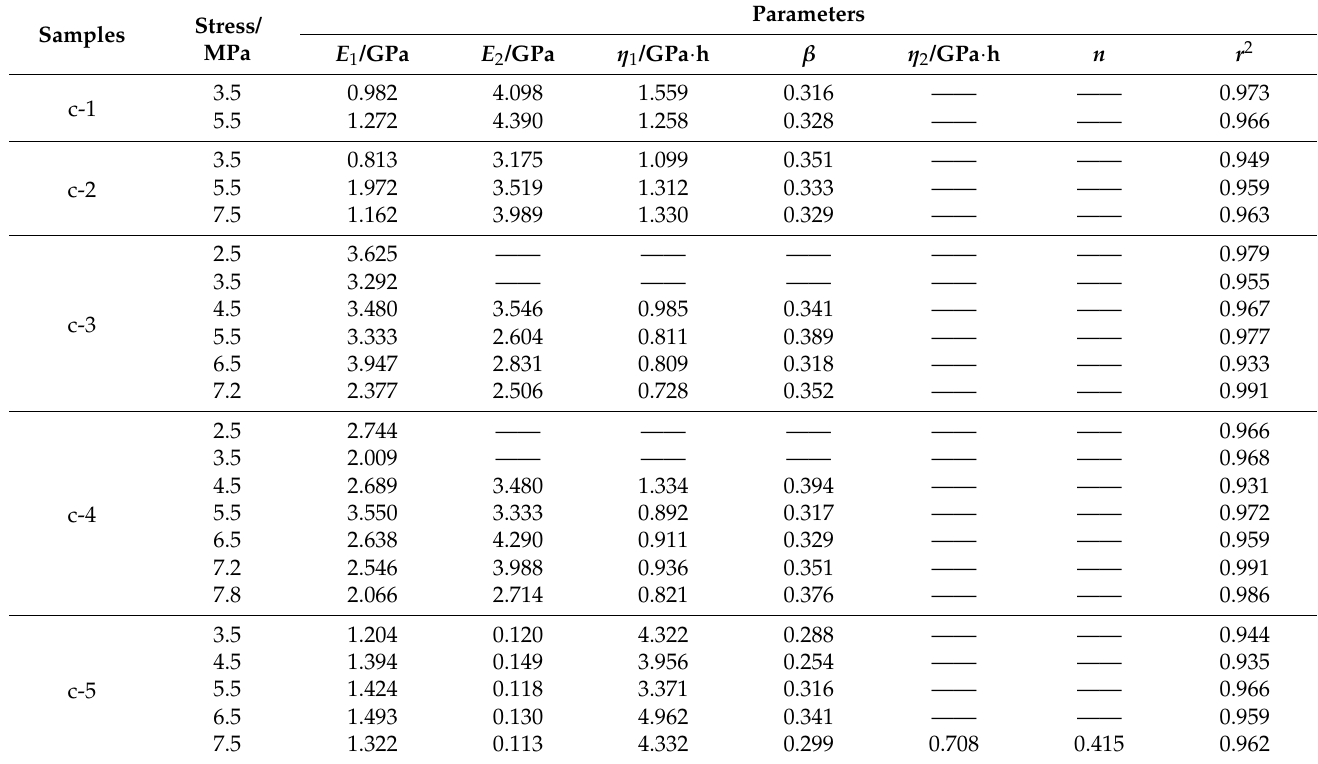
Table 3. The parameters identified in the creep tests in the core damage